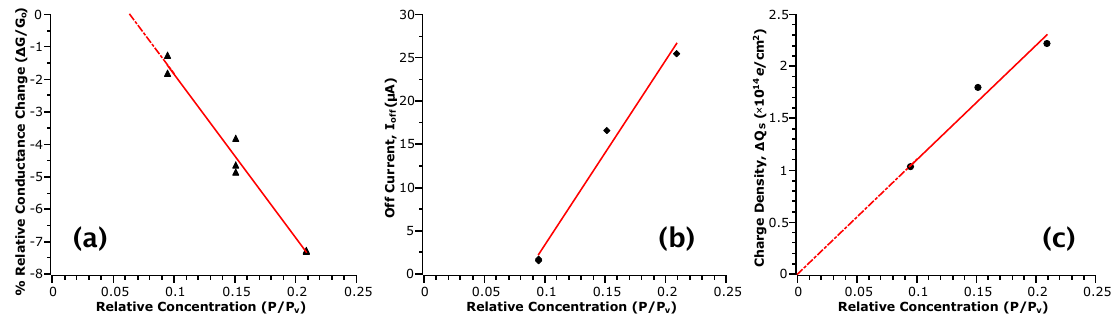
Figure 4. Sensor responses correlated with P / P v . Red lines are a linear fit to the data and serve as a guide to the eye. ( a ) is extracted from the relative conductance change before and after removal of analyte from the sensing chamber, where G o is the conductance before; ( b ) is the off current defined as I DS ( − 10V) from the I DS - V GS curves; ( c ) is the differential surface charge density extracted from values of subthreshold swing obtained from the log ( I DS ) - V GS